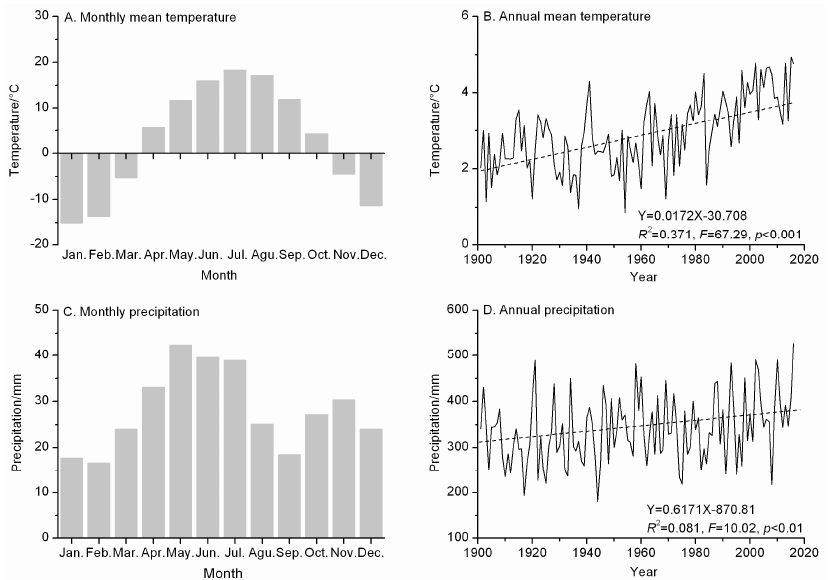
Figure 2. Gridded climatic data for the study area during 1901–2016: ( A ) monthly and ( B ) annual mean temperature; ( C ) monthly and ( D ) annual precipitation. Dashed lines represent trends in climatic data.